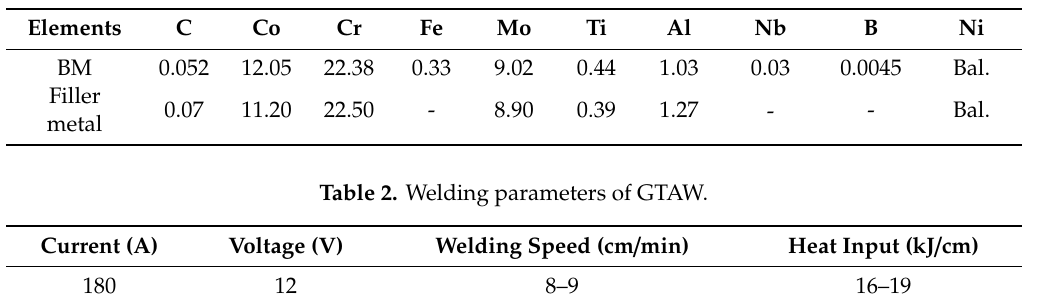
Figure 1. Schematic diagram of ( a ) the set-up structure and ( b ) groove of 617B GTAW (mm). ( c ) Micrograph of welded joint section (OM). Table 1. Chemical compositions of BM and filler metal (wt %).